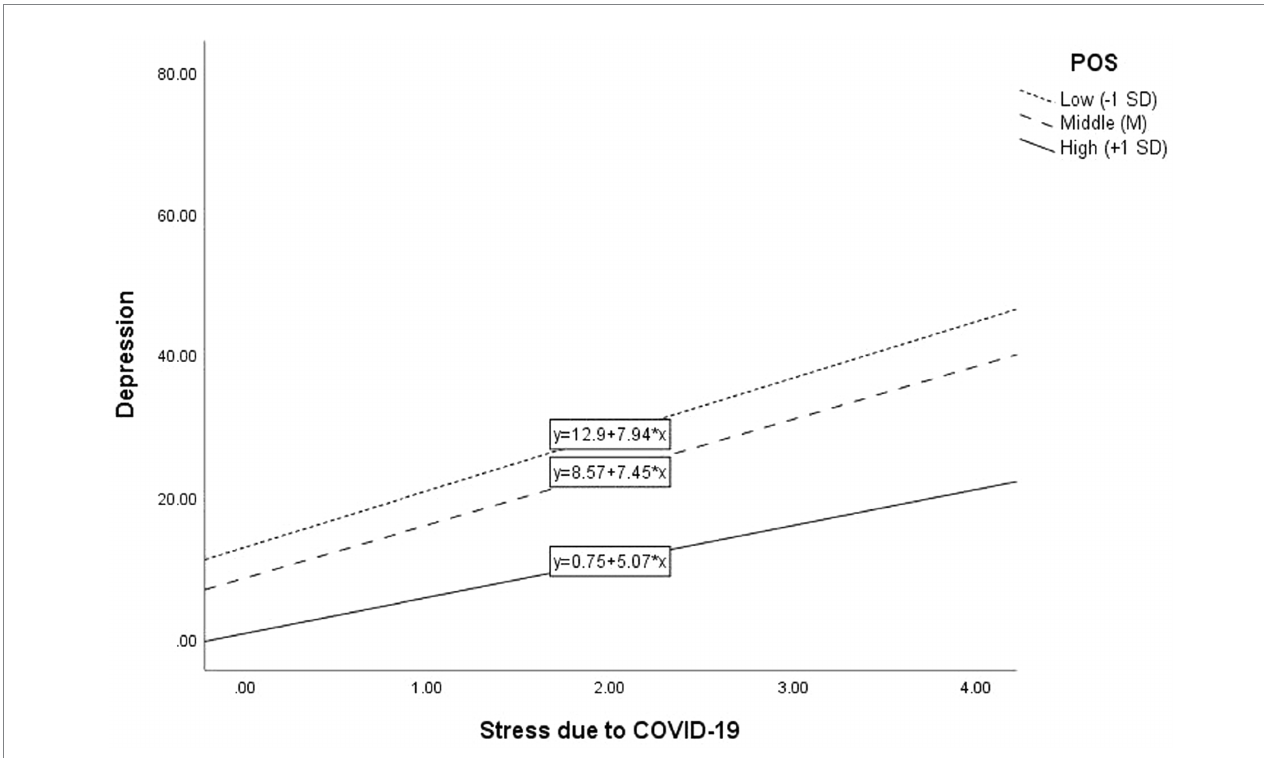
FIGURE 1 Moderating effect of composite positive psychological factors (POS) on the relationship between COVID-19 Stress and